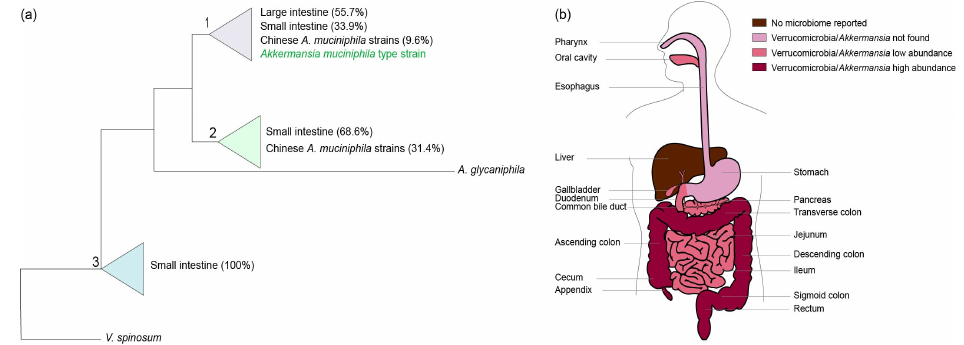
Figure 1. ( a ) Akkermansia is not only present in the large intestine, but also in other anatomic regions of the digestive tract. A schematic overview of the positioning of 16S rRNA clones in the small